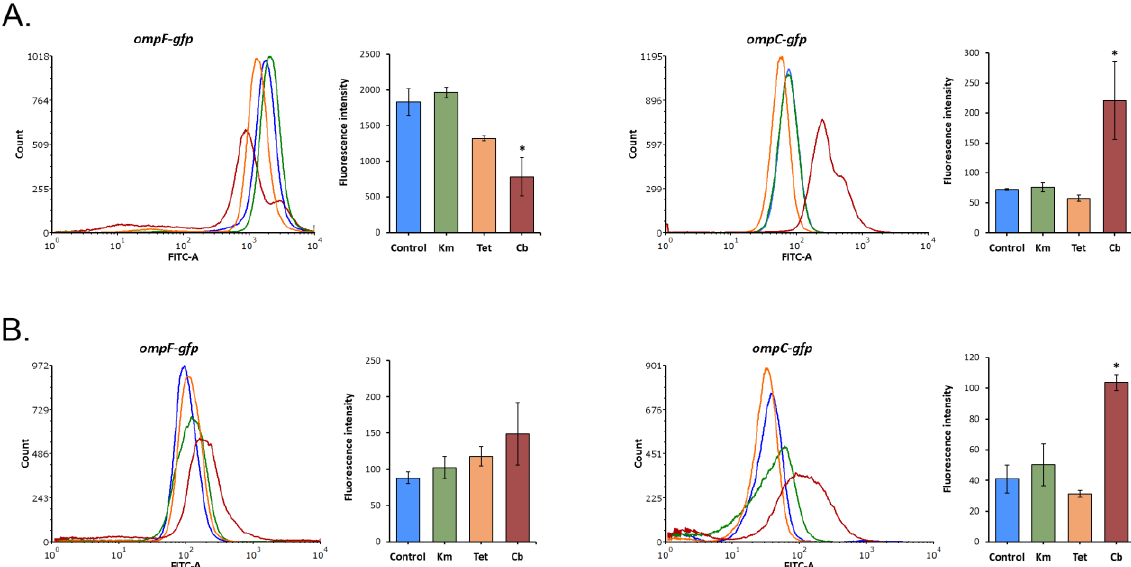
Figure 5. GFP fluorescence intensity in Y. pseudotuberculosis 488 transformed with ompF / ompC promoter-fused GFP reporter constructs following 16 h antibiotic treatment monitored by flow cytometry. ( A ) 27 °C incubation temperature; ( B ) 37 °C incubation temperature. All results are expressed as mean ± standard deviation between three experimental trials. An asterisk indicates p -value < 0.05 vs. respective control. Significance was calculated using one-way ANOVA. The histograms from a single representative experiment are shown. Control — without antibiotic treatment, Km — kanamycin, Tet — tetracycline, and Cb — carbenicillin.